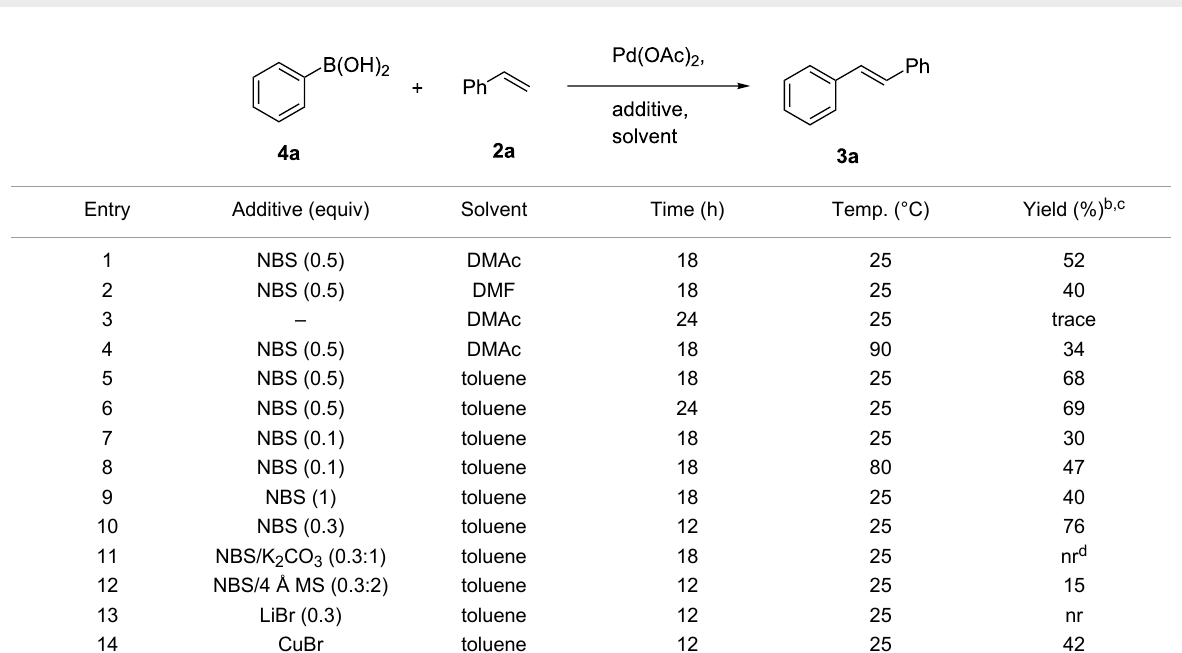
Table 3: Heck reaction of phenylboronic acid and styrene: Optimization of the reaction conditions.